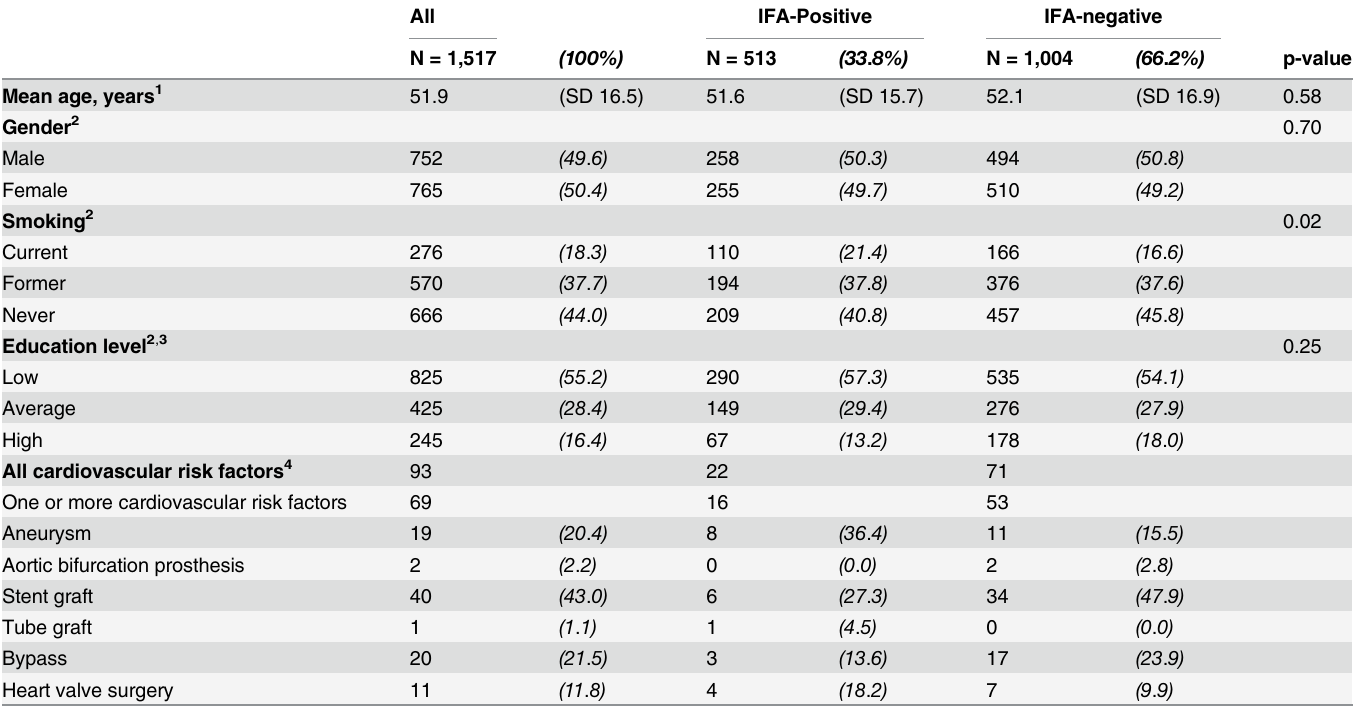
Table 1. Characteristics of the study participants.